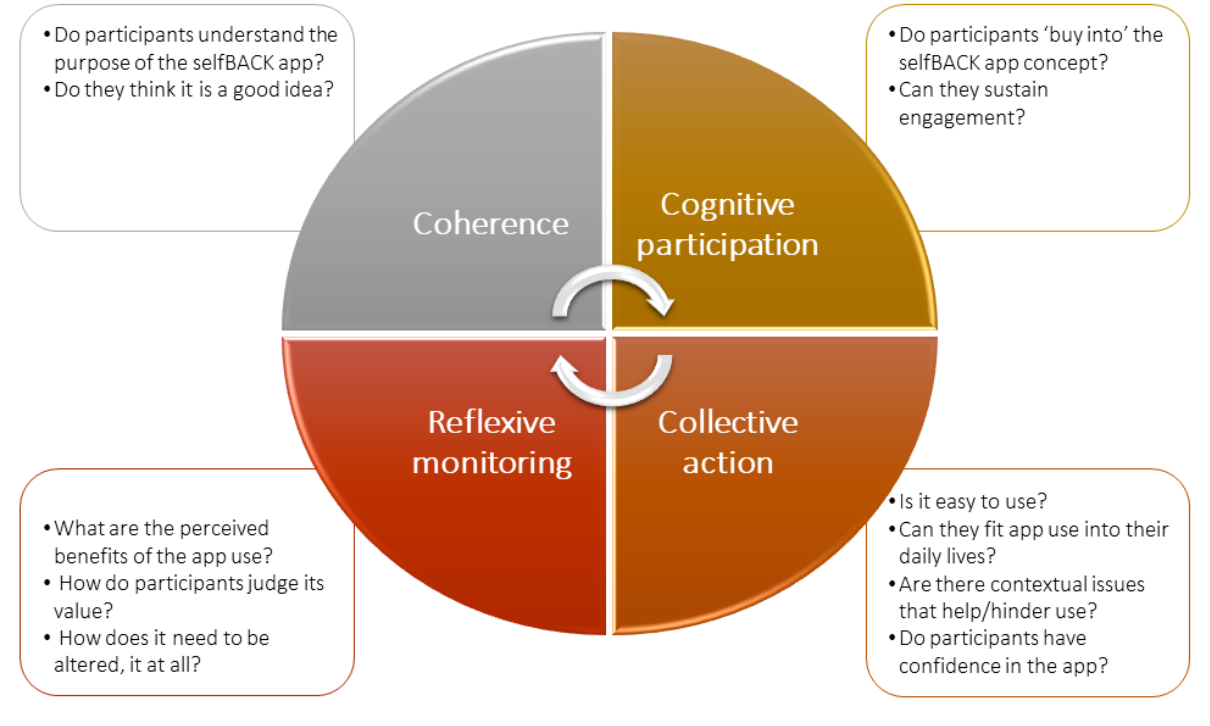
Figure 1. Four constructs of normalization process theory and associated questions from the process